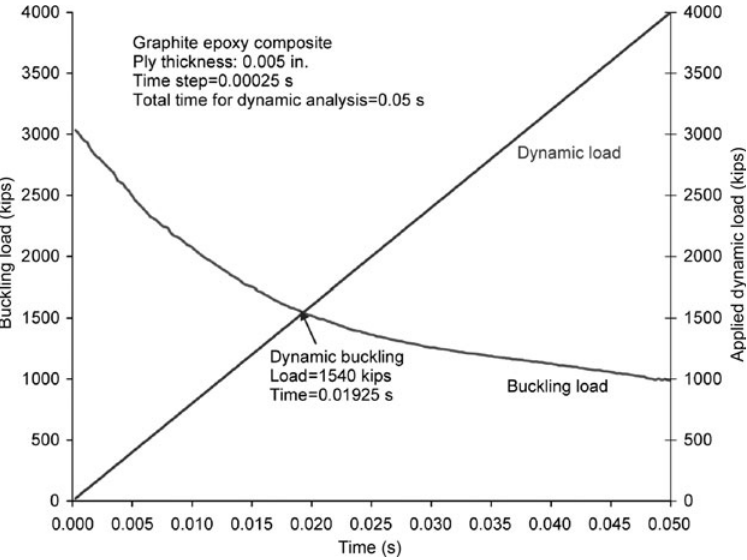
Figure 2 Effect of time on the buckling load and applied dynamic load (composite shell with dynamic compressive axial loading). (1 in. = 2.54 cm; 1 kip = 4.45 KN.)